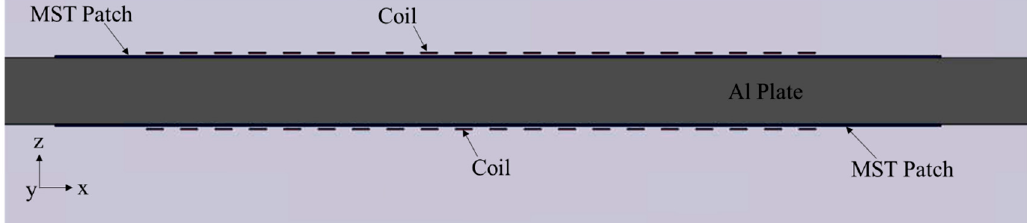
( d ) Figure 9. Effect of the adhesive thickness on SH0 wave amplitude and wave modes, ( a ) normalized wave amplitude as a function of adhesive thickness. Wavenumber spectra for MST with adhesive thickness of ( b ) 0.0 mm; ( c ) 0.3 mm; ( d ) 0.6 mm. ( b , c ) and ( d ) have the same color bar. 4.2. Comparison between Single-Sided and Double-Sided MSTs Since double-sided Lorenz-force EMATs have shown superior capability in mode se- lection [15], this section considers both single-sided and double-sided MSTs to assess how effectively the MST preferentially actuates a prescribed mode at different frequencies. They are first compared for SH guided wave generation and then for Lamb wave genera- tion. 4.2.1. SH Wave MSTs To enhance the SH waves in the plate, a double-sided MST, with the design shown